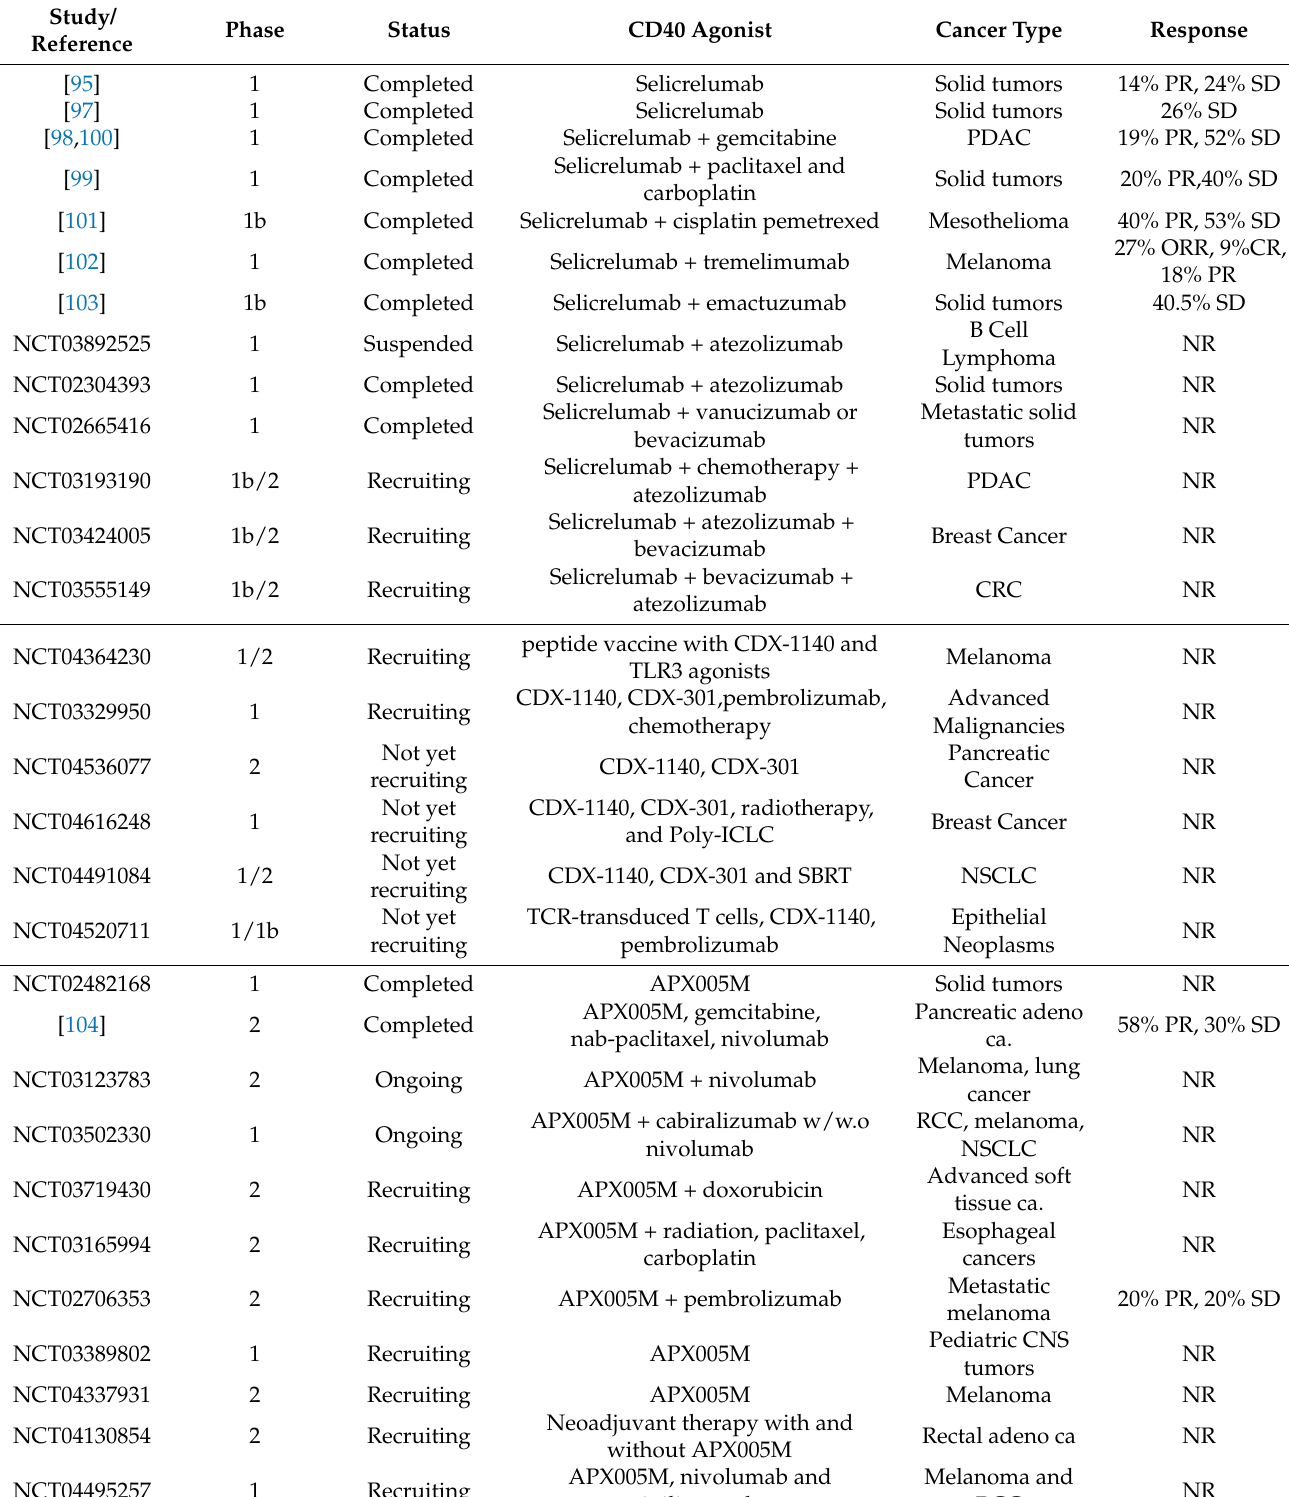
Table 2. Clinical studies of CD40 agonistic antibodies in cancer treatment, alone or in combination with other treatments. Study/